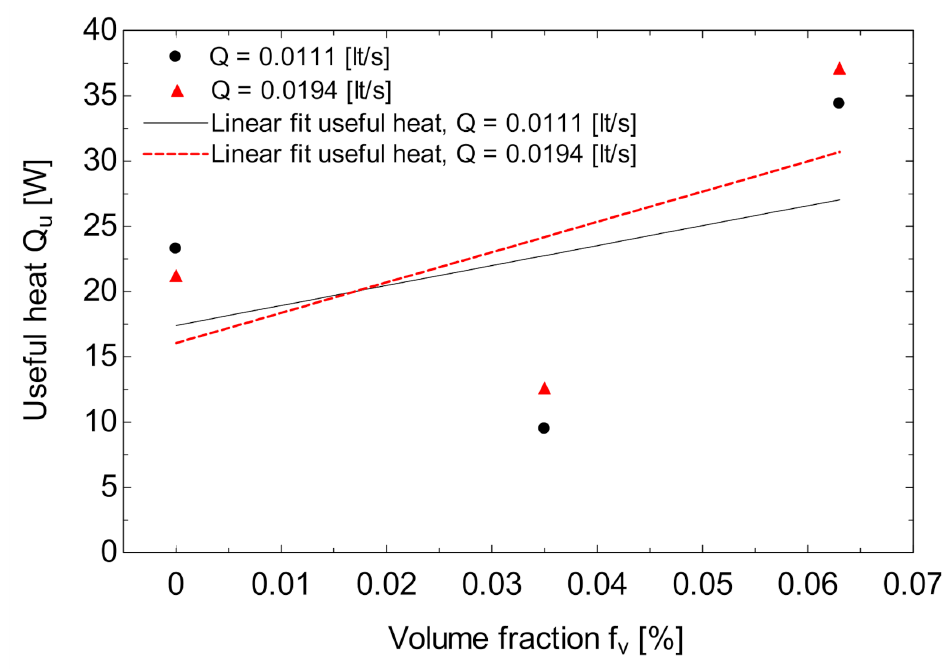
Figure 14. Average useful heat with base fluid and nanoparticles at 0.035% and 0.063% (H 2